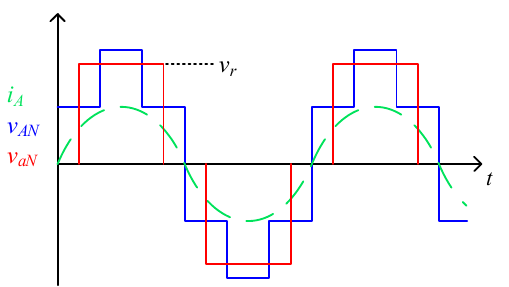
Figure 11. Simplified waveform of resonant tank and transformer.